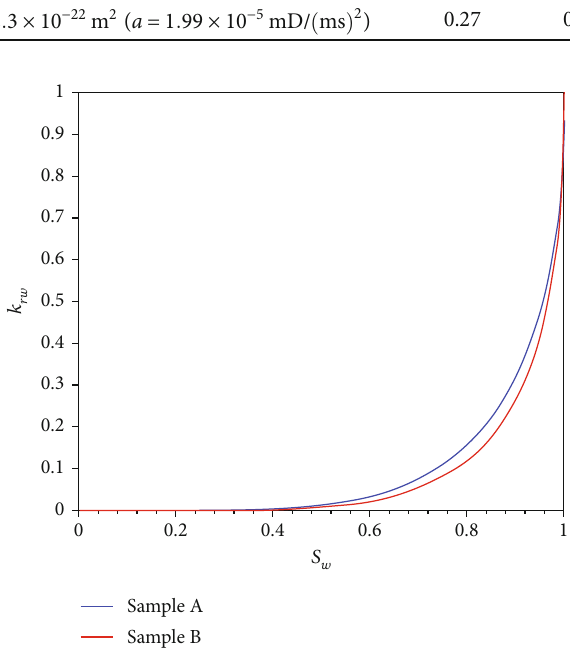
Figure 4: The variation of relative permeability with